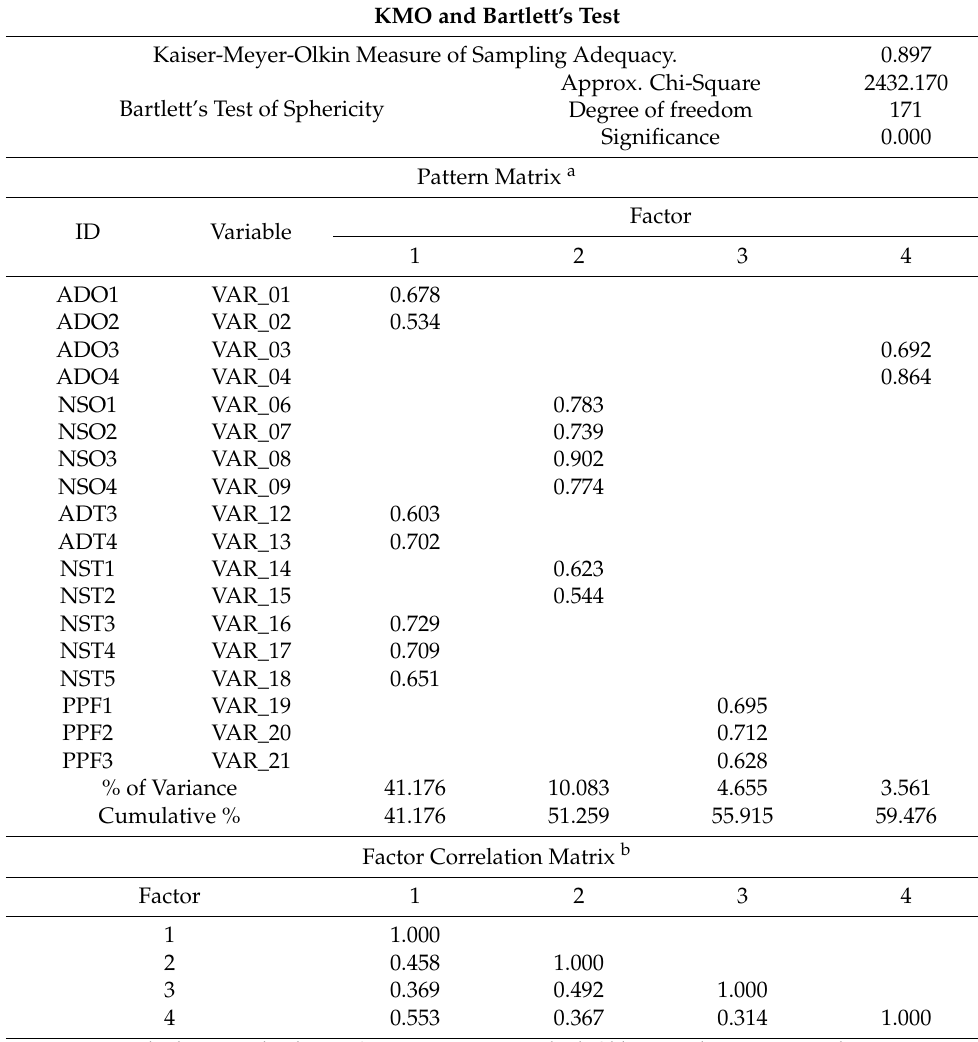
Table 4. Exploratory Factor Analysis for 4 factors.